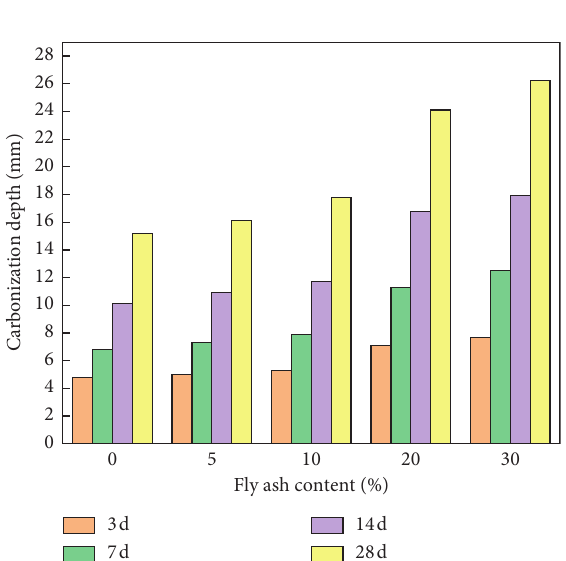
Figure 7: Effect of carbonizationg time on early carbonization